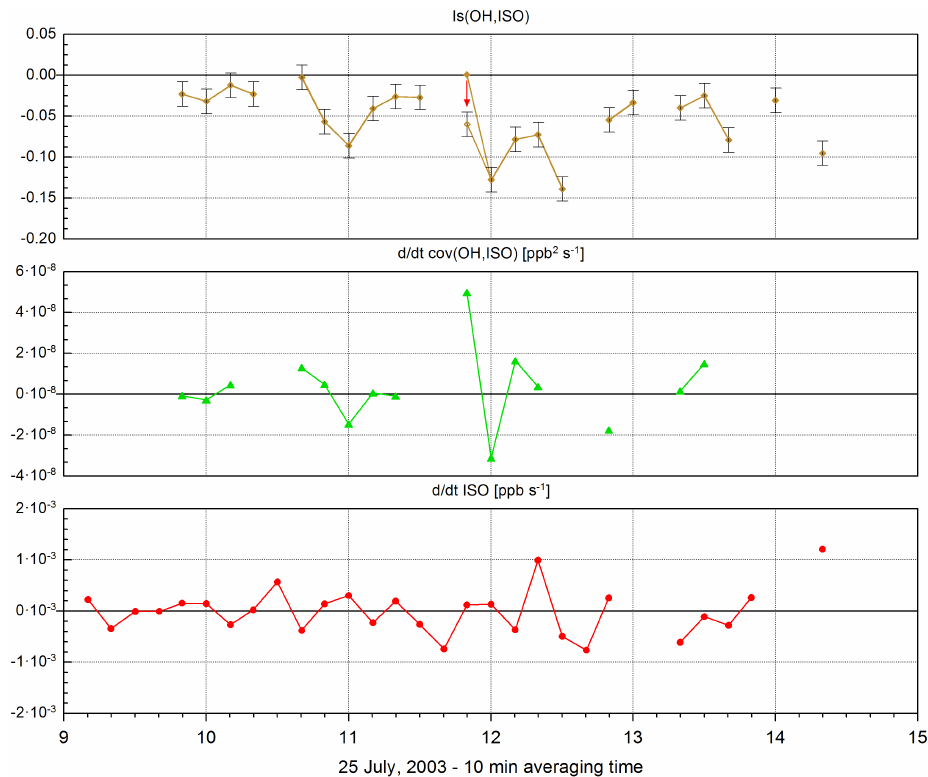
Figure 11. The storage term for the covariance between isoprene and OH from Eq. (9) compared to the storage terms of the balances of isoprene (Eq. 5) and the intensity of segregation I S as given by Dlugi et al. (2010) with the corrected data point (Sect. 5.3.4).